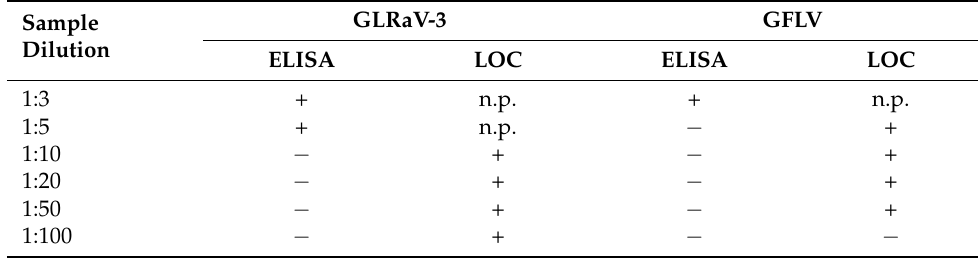
Table 3. Test results (+ = positive/detectable, − = negative/undetectable, n.p. = not performed) from analysis carried out on GLRaV-3 and GFLV samples. A comparison of results reveals a higher sensitivity of LOC with respect to ELISA